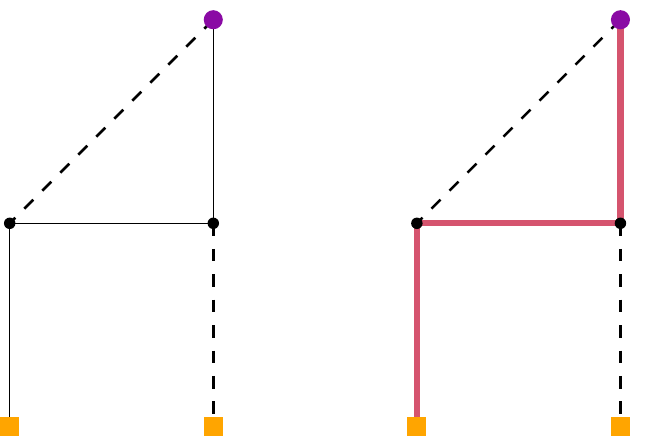
Fig 1. CSPH example. The large purple circle is the root. The yellow square nodes are the terminals. The left image has no connections. In the right image, a single path connects the root to a terminal.